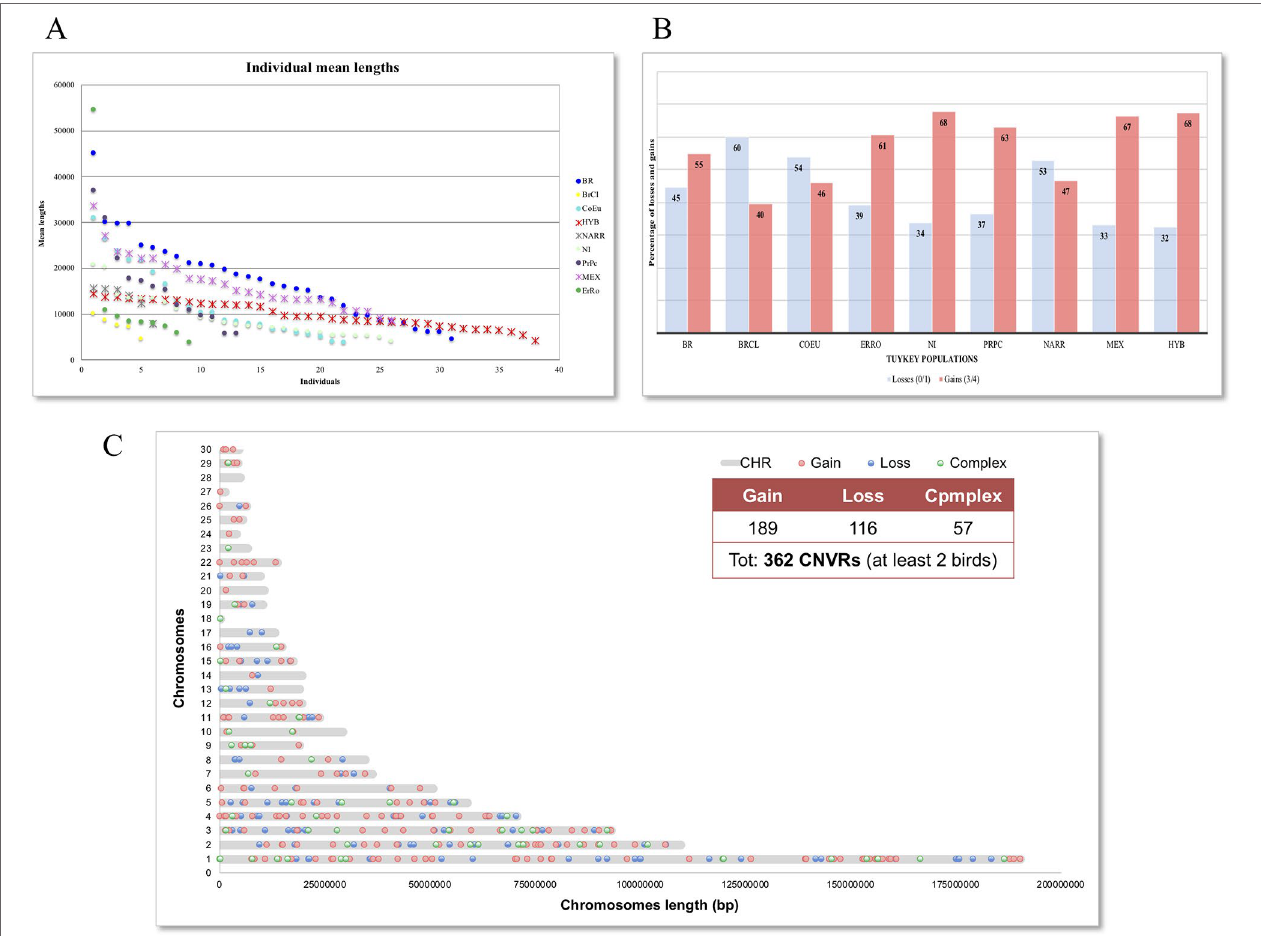
TABle 3 | Summary of CNVRs identified for each turkey’s population.